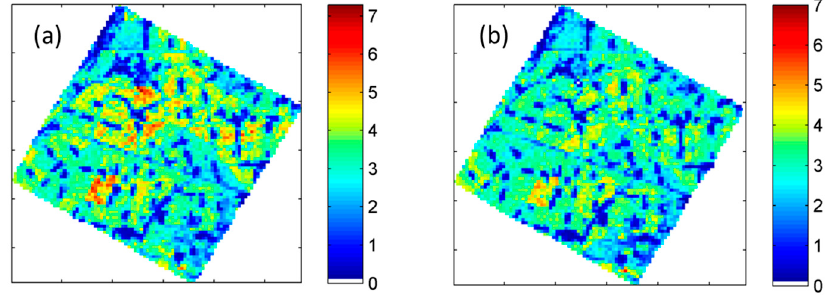
Figure 4. Distribution of LAI values within the study area on ( a ) 10 July 2012 and ( b ) 2 August